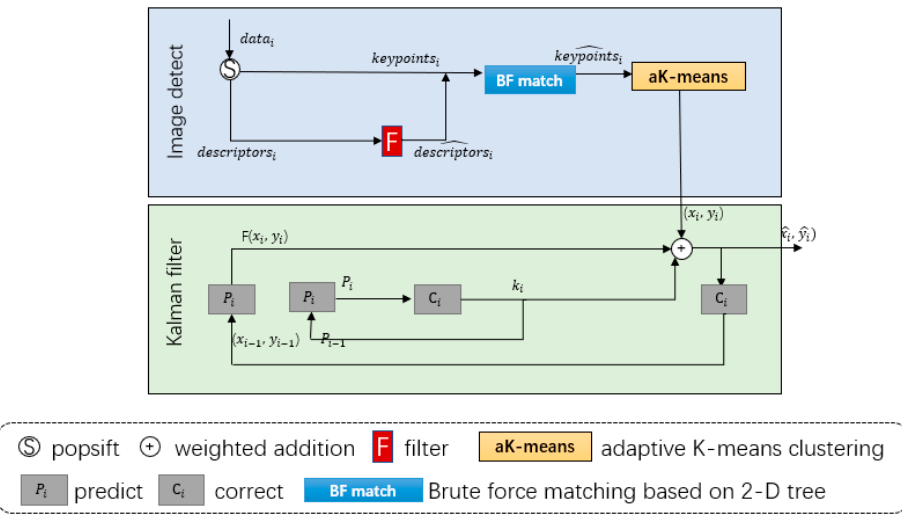
Figure 5. Logic diagram of video object location model.